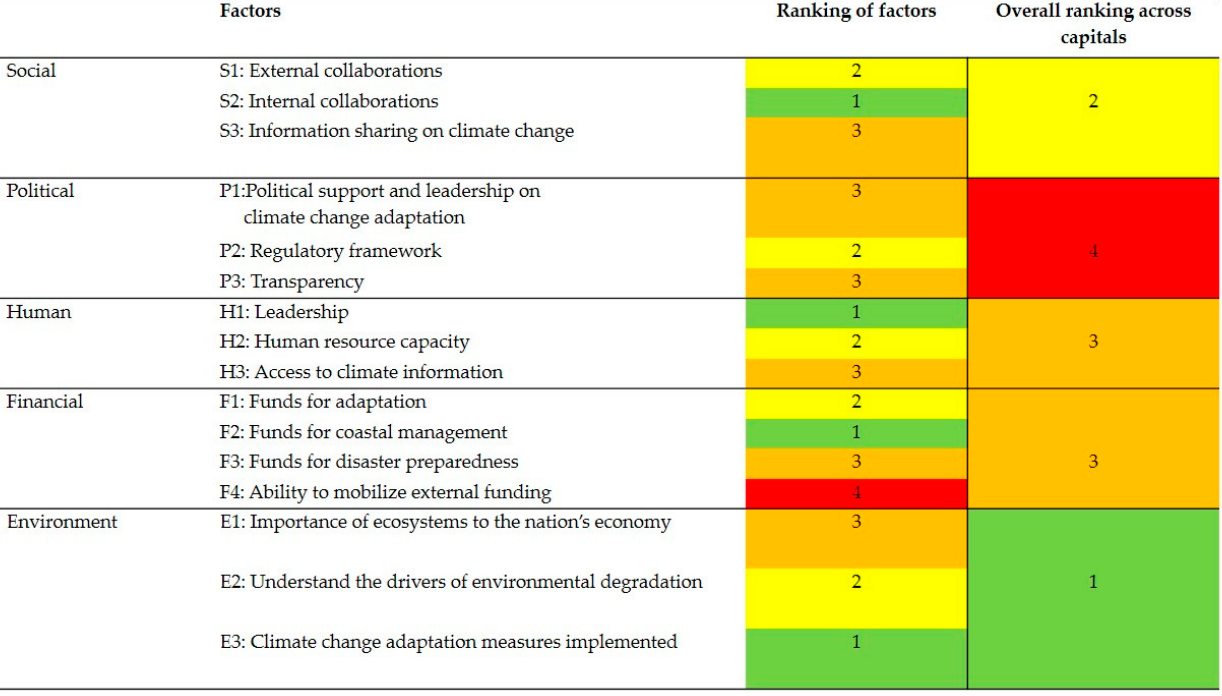
Figure 4. Ranking of factors across each capital based on a consensus approach. Note: High (1); Medium (2); Low (3); Very low (4).